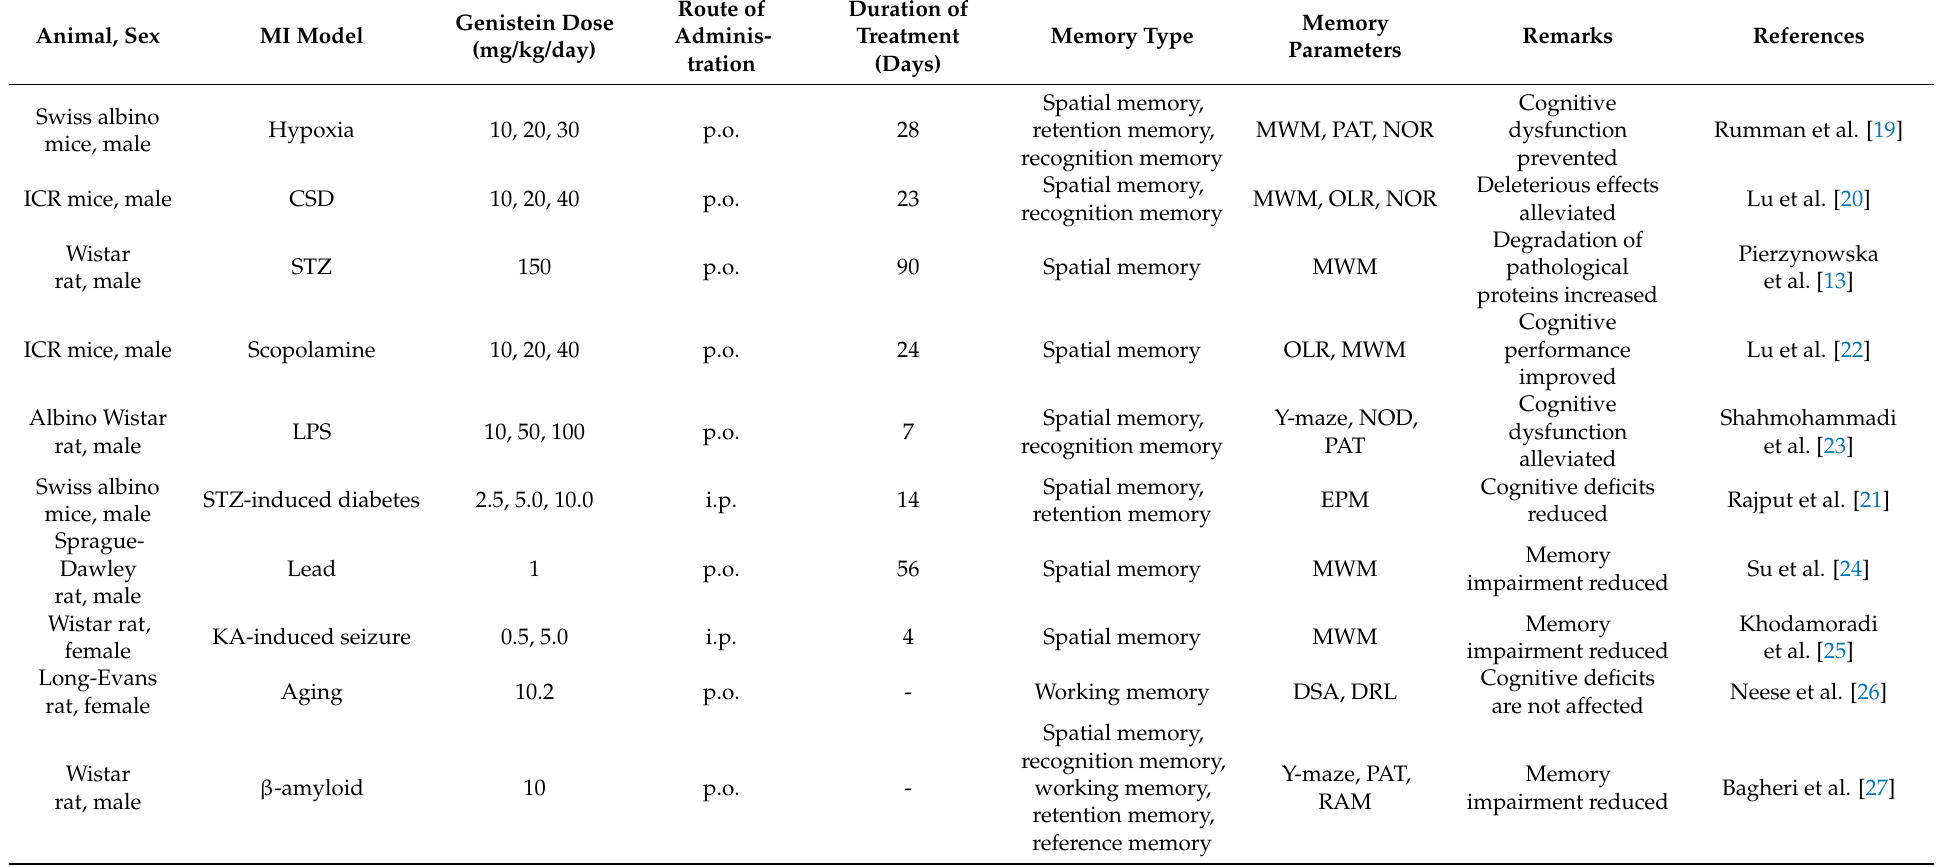
Table 1. A summary of in-vivo studies investigated the efficacy of genistein on memory